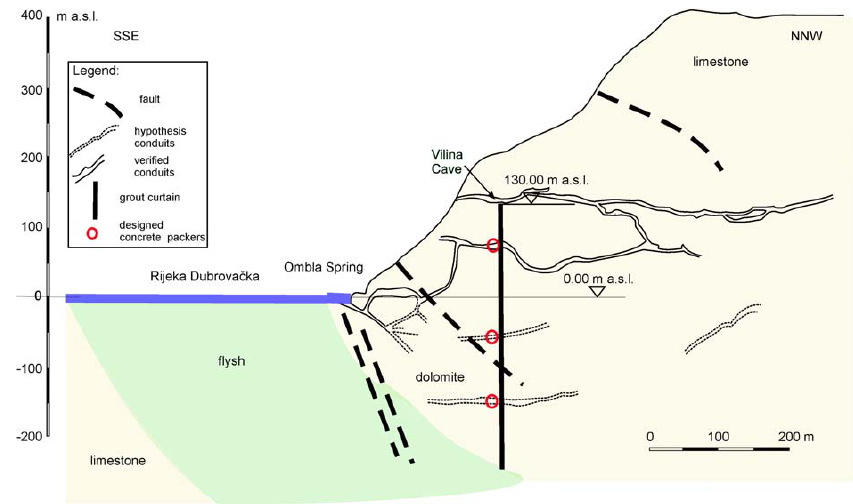
Figure 8 Fig. 8. Cross-section through the system of explored karst caves and large conduits in the vicinity of the Ombla Spring, indicating the location of some key parts of the projected HEPP Ombla, grout curtains and concrete blocks (modified after Ravnik and Rajver, 1998; Sever,